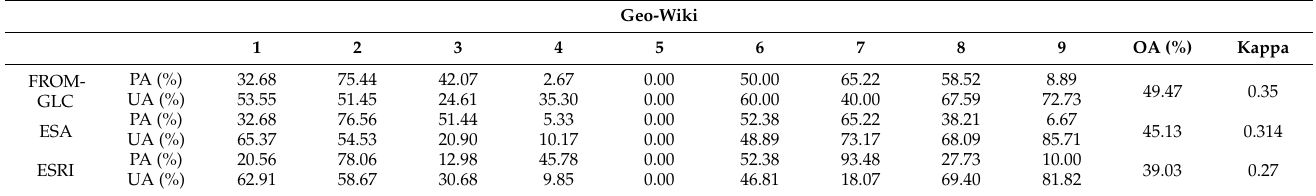
Table 5. Accuracy evaluation results based on Geo-Wiki samples.